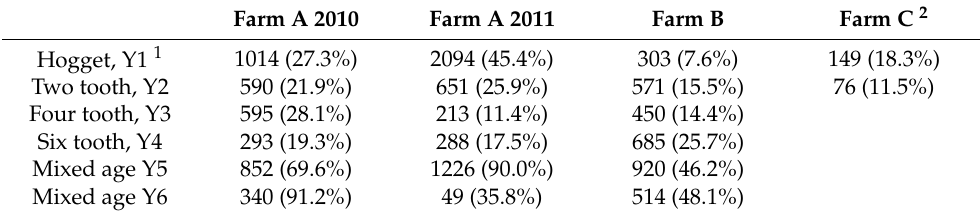
Table 4. Annual wastage: of the ewes that remained in each cohort at the start of each production year (pre-mating), the number (and percentage) of ewes that exited in that production year (Years 1–6) due to wastage (combination of premature culling and dead/missing), for each cohort.